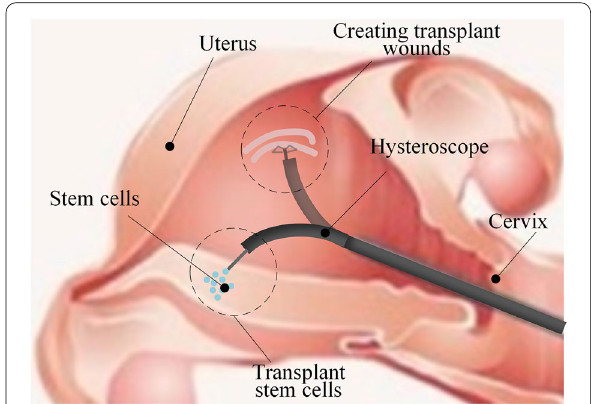
Figure 1 Operations during endometrial regeneration